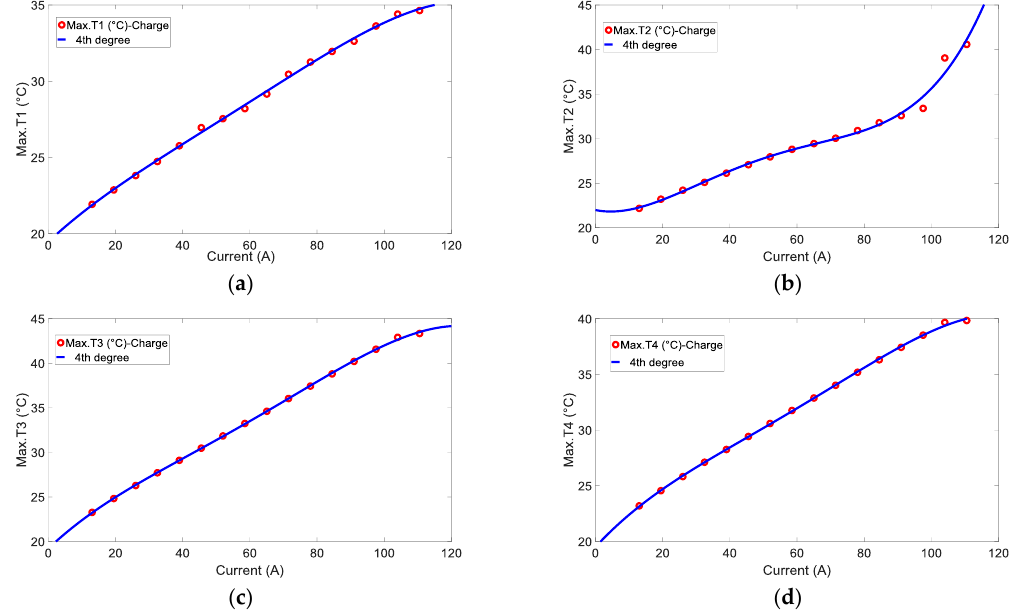
Figure 13. Maximum temperatures evolution and their curve fitting during charge. ( a ) Max. T 1 -Charge; ( b ) Max. T 2 -Charge; ( c ) Max. T 3 -Charge; ( d ) Max. T 4 -Charge.